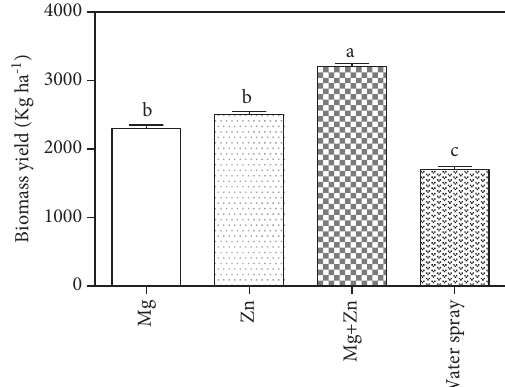
Figure 3: Impact of treatment on biomass yield. Bars with different letters in the figure are statistically different at P < 0 . 05. Error bars represent the standard error of means. Means comparison was done using Tukey HSD (honestly significant difference) ( P < 0 .